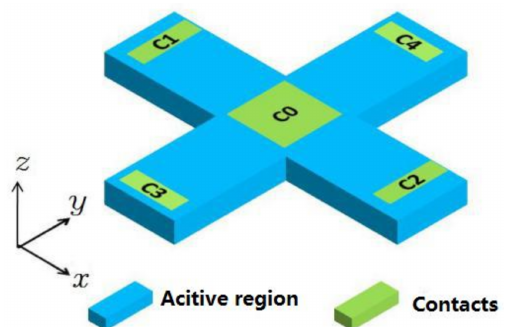
Figure 10. Diagram of the cross-shaped 3D Hall device. Two orthogonal three-contact vertical Hall devices are placed in a cross shape.